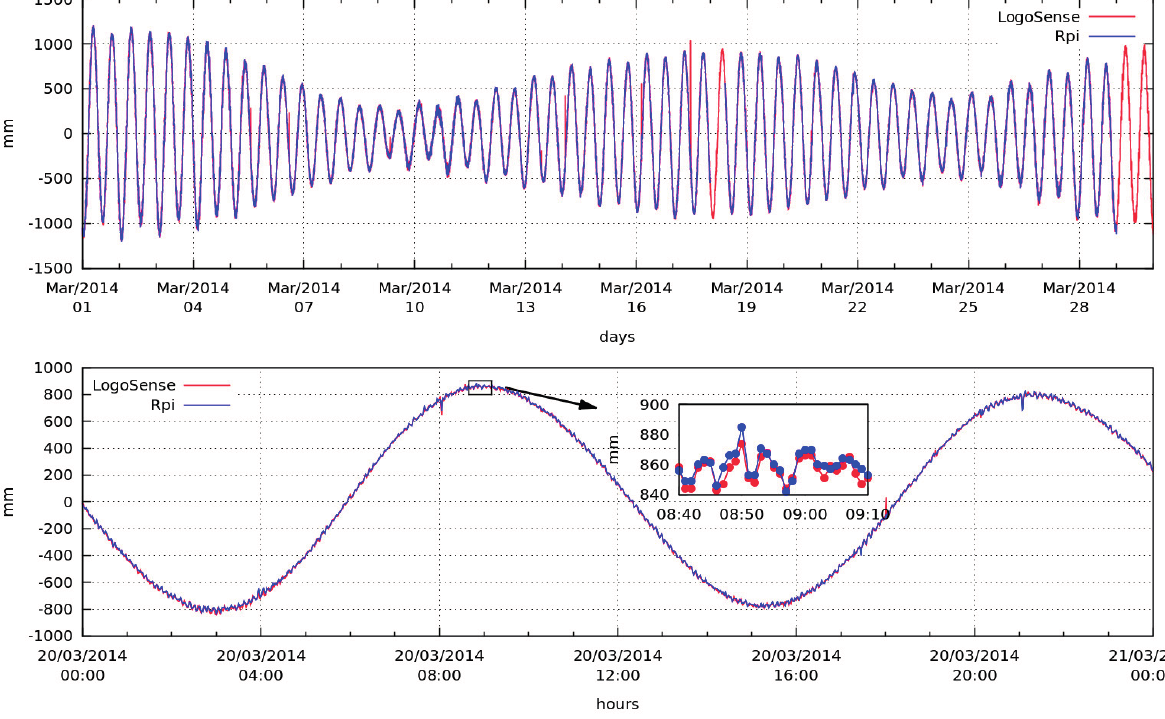
Figure 15. Ocean tide registered by a commercial acquisition system and by the system developed in this project over a period of thirty days. Top: the measurements obtained by the LogoSens datalogger (in red) and the measurements produced by the datalogger developed in this project (Rpi) (in blue). Bottom: the same signal over a period of 24 hours with a zoom showing the noise present in both